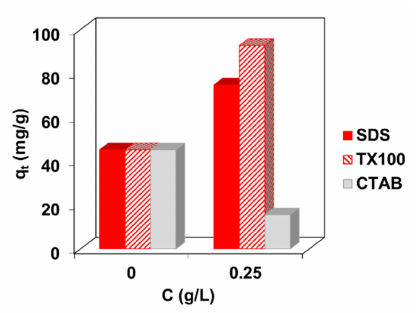
Figure 5. Influence of the surfactants presence on BR46 uptake by C/SiO 2 in the 100 mg/L BR46 + 0.25 g/L surfactants (SDS, TX100, CTAB) systems. 0.25 g/L surfactants (SDS, TX100, CTAB)